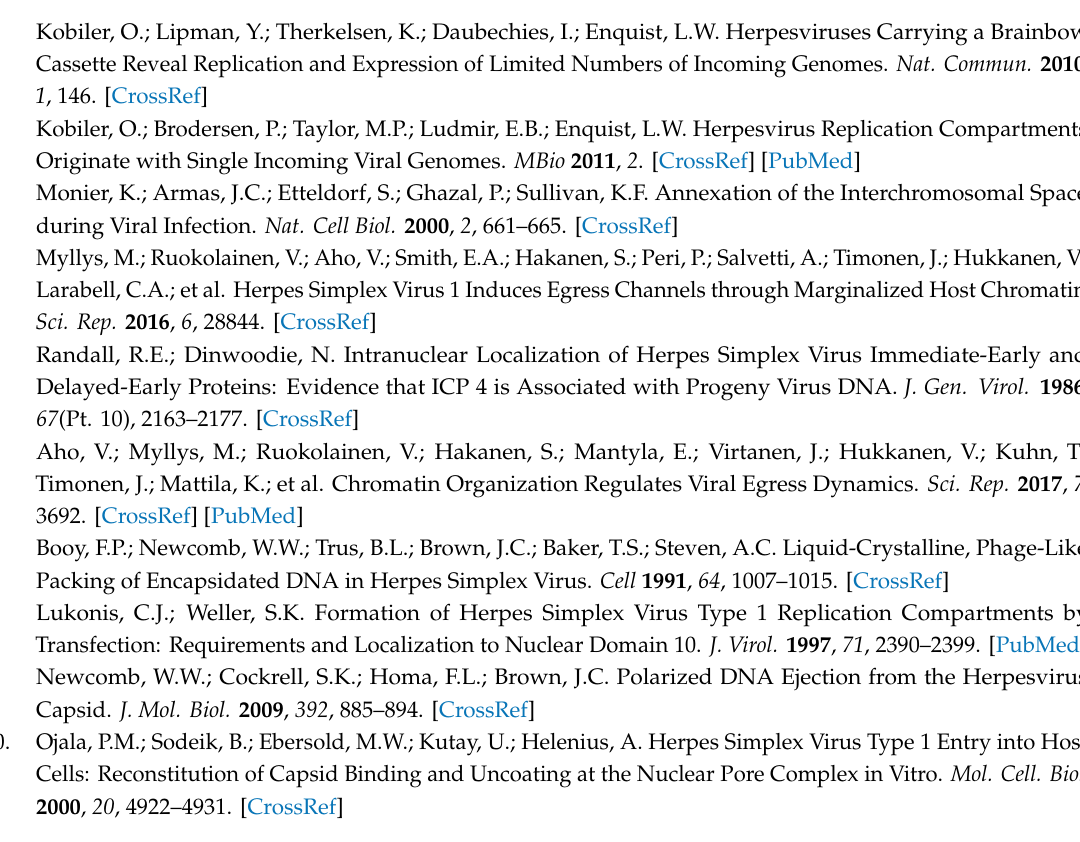
Figure S1: Live cell time-lapse imaging of chromatin marginalization in Vero cells, Figure S2: Live cell time-lapse imaging of the formation of HSV-1 replication compartment in B cells, Movie S1: Time-lapse imaging of VRC maturation in Vero cells, Movie S2: Time-lapse imaging of VRC maturation human B cells, and Movie S3: Simulated capsid